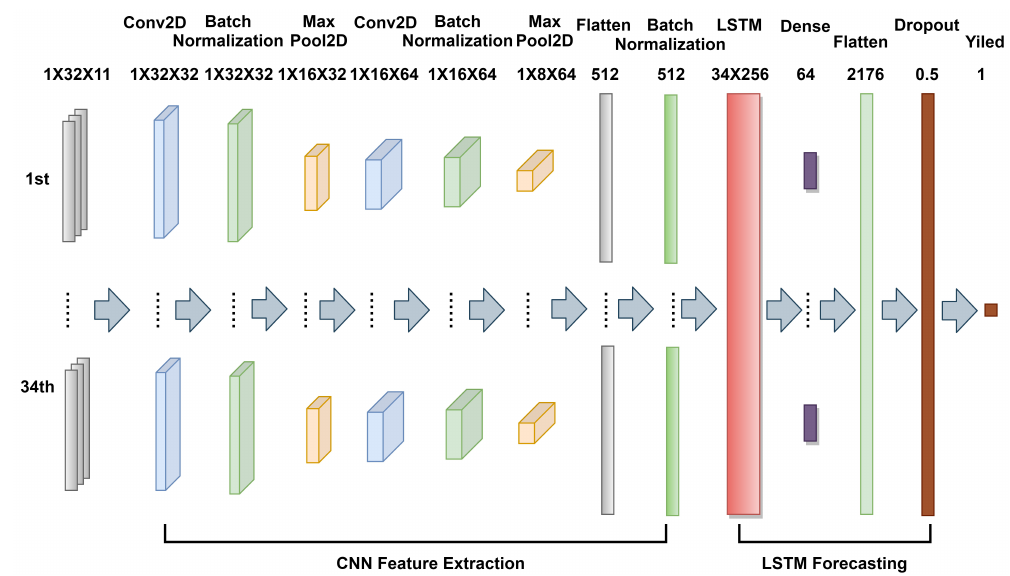
Figure 3. The architecture of the proposed CNN-LSTM